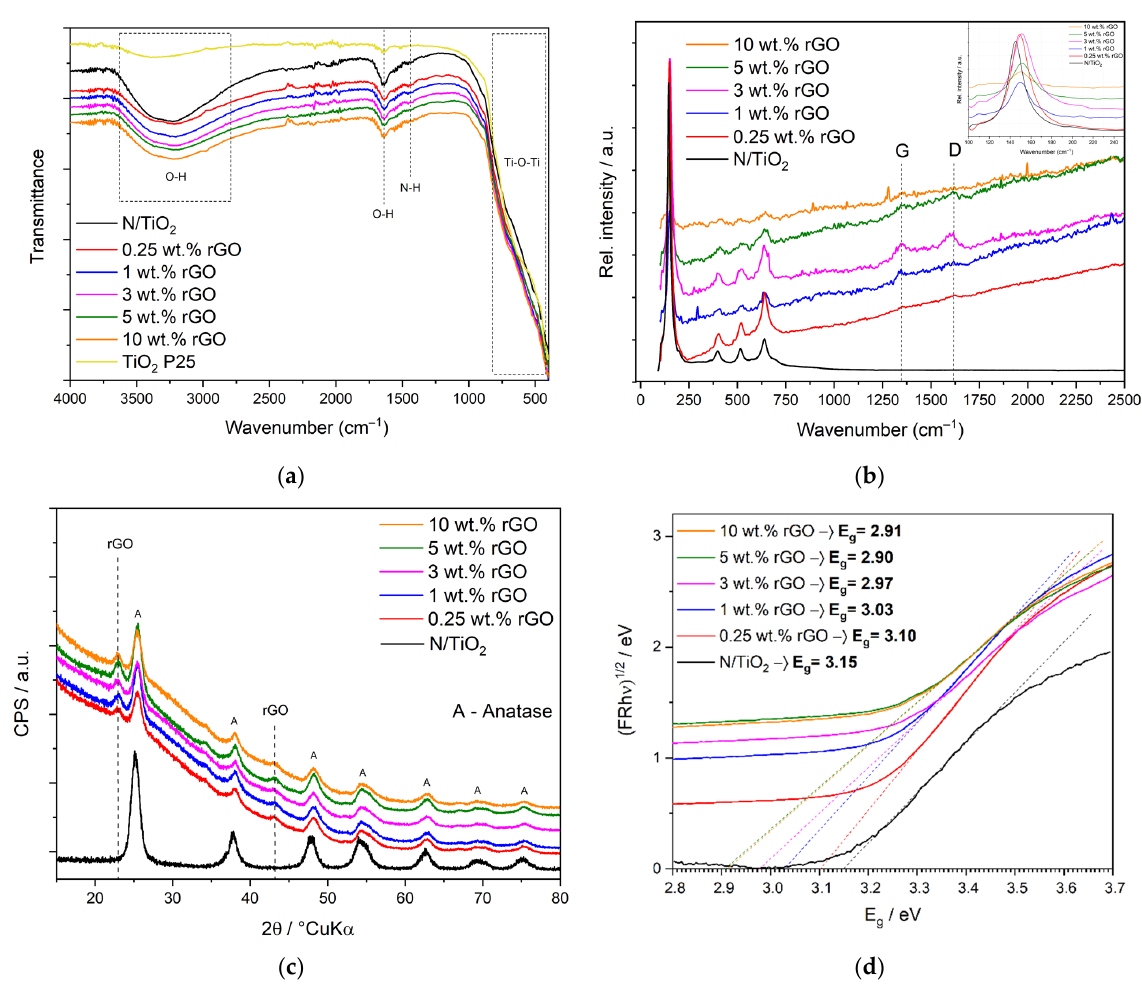
Figure 2. ( a ) FTIR spectra, ( b ) Raman spectra, ( c ) X-ray diffraction patterns, and ( d ) Tauc plot for energy bandgap determination of N/TiO 2 and N/TiO 2 /rGO photocatalysts with different amounts of rGO (0.25, 1, 3, 5 and 10 wt.%). Table 2. Elemental composition of N/TiO 2 and N/TiO 2 /rGO photocatalysts determined by SEM-EDS analysis. Elemental Composition, wt.% Material Ti O C N N/TiO 2 72.0 21.0 – 7.0 N/TiO 2 /rGO 0.25 wt.% 83.7 – N/TiO 2 /rGO 1 wt.% – N/TiO 2 /rGO 3 wt.% 85.0 – N/TiO 2 /rGO 5 wt.% 85.1 – N/TiO 2 /rGO 10 wt.% 86.3 1.8 – Table 3. Bulk composition of N/TiO 2 and N/TiO 2 /rGO photocatalysts determined by XPS analysis. Elemental Composition, wt.% Material Ti O C N N/TiO 2 21.5 N/TiO 2 /rGO 0.25